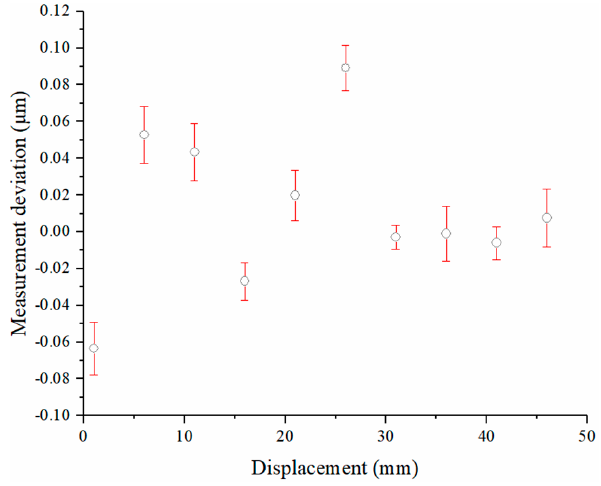
Figure 17. Measurement deviation calculated based on the new linear coefficient c.